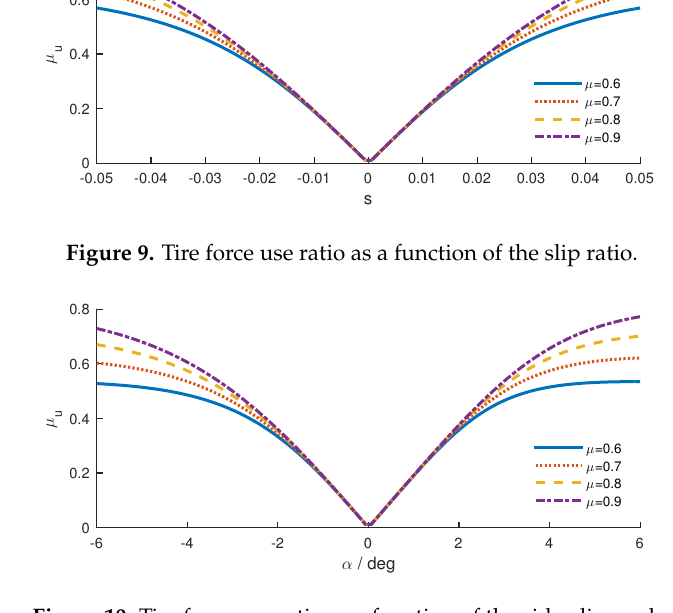
Figure 10. Tire force use ratio as a function of the side-slip